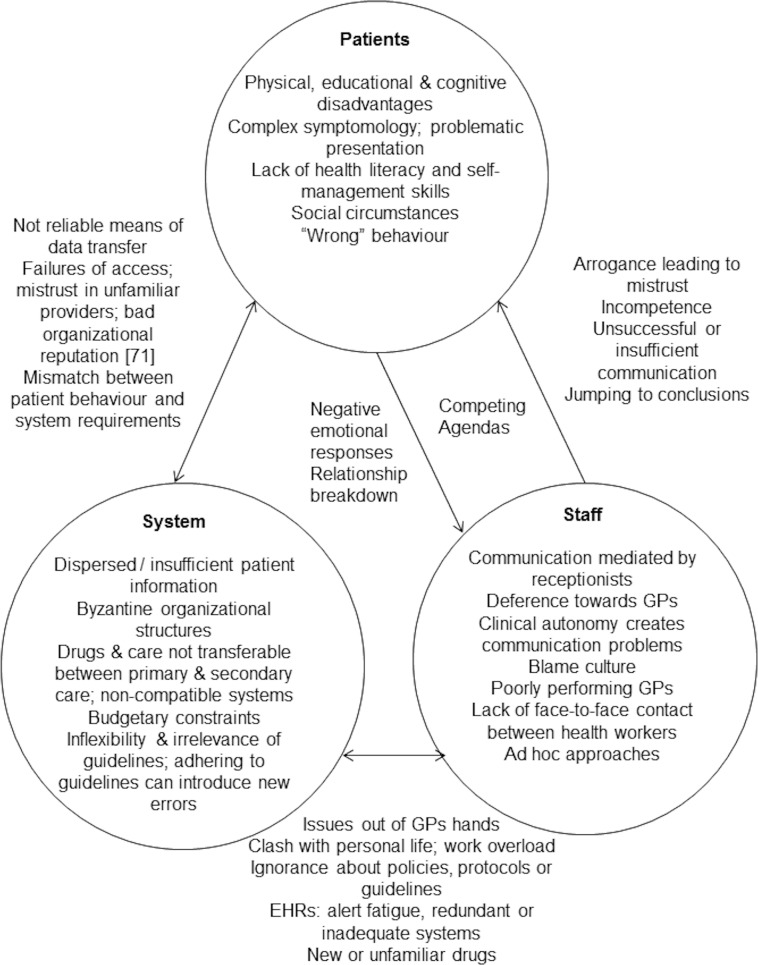
Degrading Patient Safety in Primary Care.